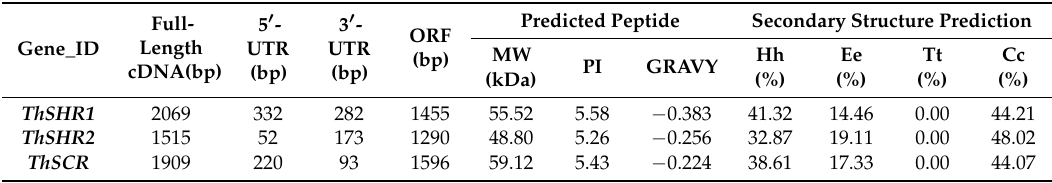
Table 2. Features of the ThSHR1 , ThSHR2 and ThSCR.